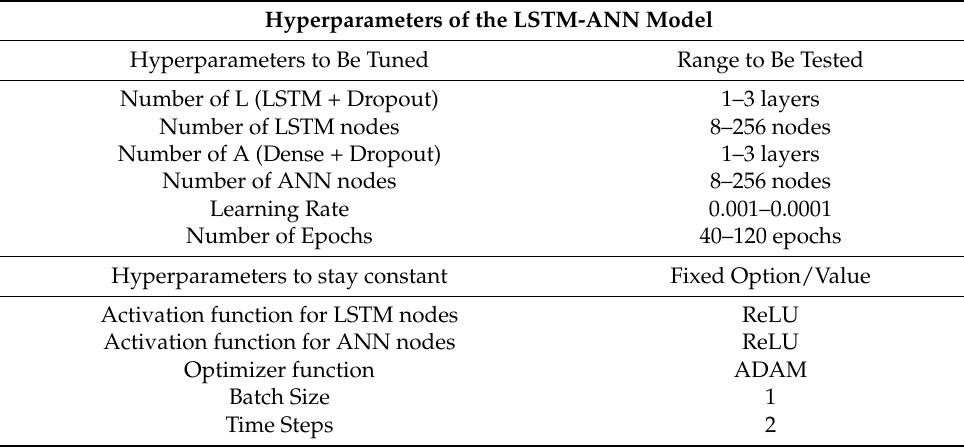
Table 2. Hyperparameters that will be fixed and tested in the LSTM-ANN model. Hyperparameters of the LSTM-ANN Model Hyperparameters to Be Tuned Range to Be Tested Number of L (LSTM + Dropout) 1–3 layers Number of LSTM nodes 8–256 nodes Number of A (Dense + Dropout) 1–3 layers Number of ANN nodes 8–256 nodes Learning Rate 0.001–0.0001 Number of Epochs 40–120 epochs Hyperparameters to stay constant Fixed Option/Value Activation function for LSTM nodes ReLU Activation function for ANN nodes ReLU Optimizer